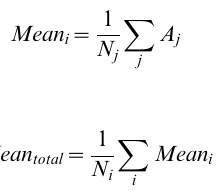
Figure S1 Examples of genetic sequence lengths and expression values for genes with low and high variability and median , 1, median , 3. Genes were ordered by increasing variability (A) or median (B) value, and sets of ten consecutive genes were randomly selected around the ends of the ranges of values seen in Figure 4A– D for variability (A), and at low median ( , 1) or about peak median ( , 3) (B). For each category here the values are ordered.